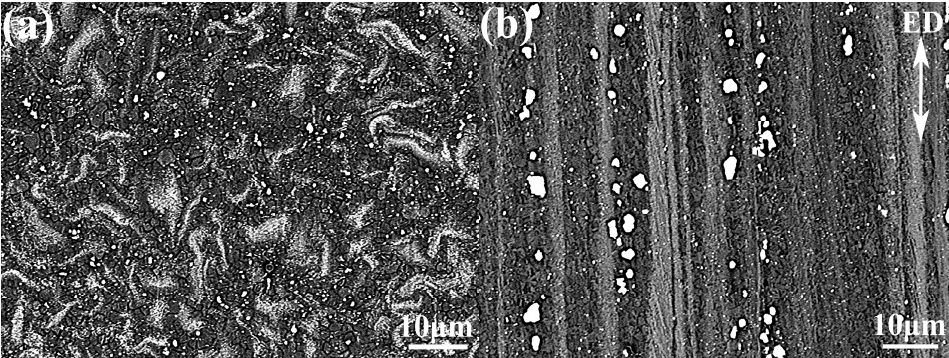
Figure 6. SEM micrograph of the Mg–Zn–Y–Nd alloy with two-pass hot extrusion: ( a ) cross-sectional microstructure showing the ultrafine grains, ( b ) longitudinal–sectional microstructure showing the paralleled elongated grains and linearly distributed secondary phase.